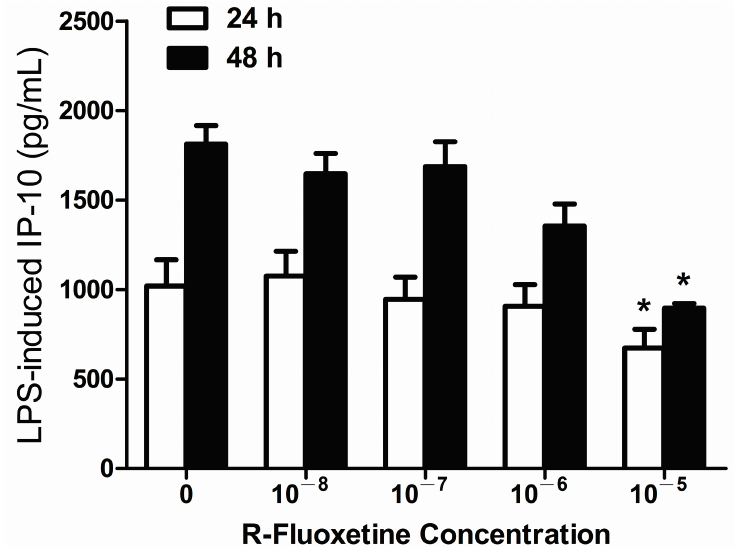
Figure 2. R-fluoxetine (10 − 5 M) suppressed LPS-induced IP-10 expression in THP-1 cells at 24 and 48 h after LPS (0.2 µg/mL) stimulation. * p < 0.05 compared with the control (LPS-untreated